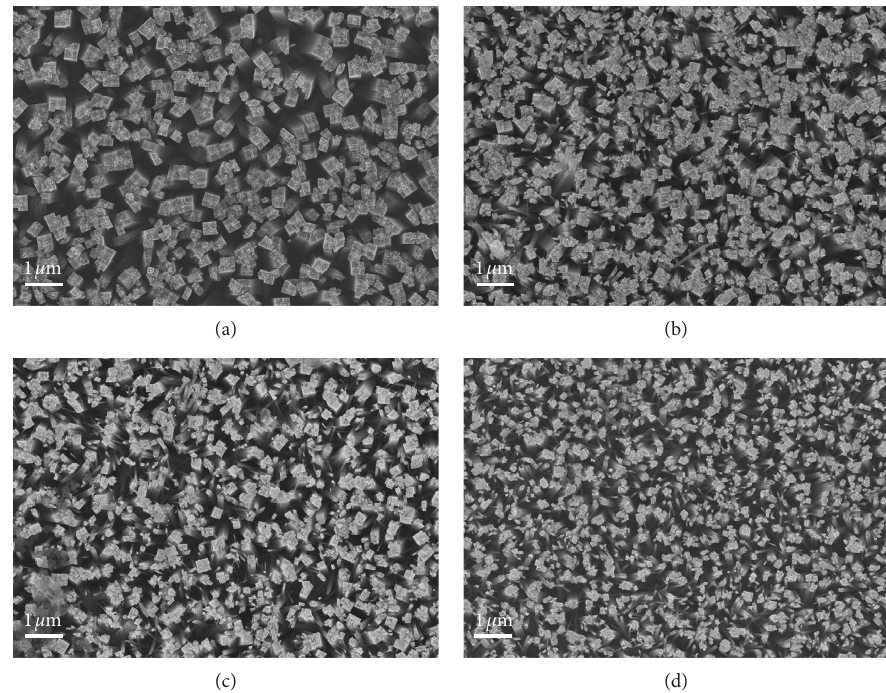
Figure 2: FESEM images of nanorods synthesized with different NaCl concentrations: (a) 0M, (b) 0.55M, (c) 0.7M, and (d) 0.85M.